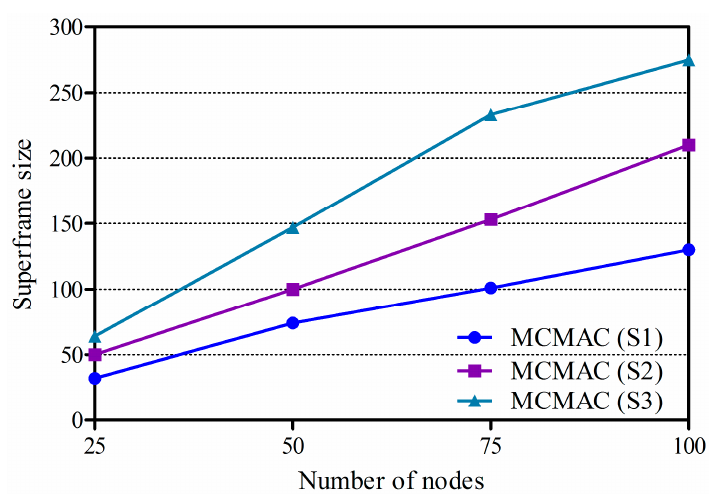
Figure 9. The size of a superframe in MCMAC according to the number of nodes (with η ( . )=1 ).